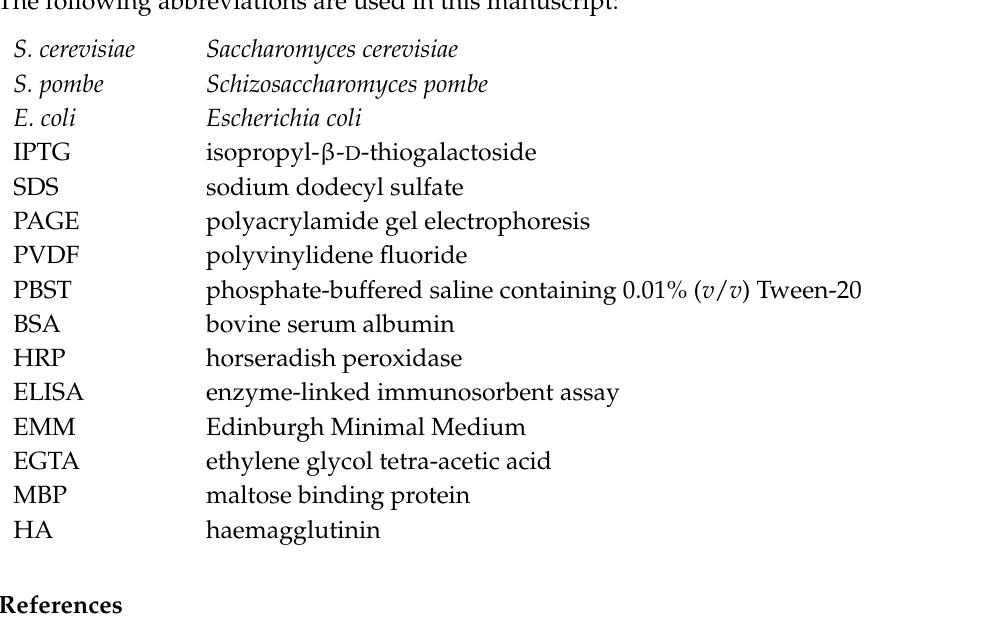
Figure S1: Performing the competitive ELISA under varying conditions, Figure S2: Effect of repeated antibody stripping on the signal height, Figure S3: Performing the inverse ELISA under varying conditions, Figure S4: Structure of authentic and chimeric pheromone genes, Figure S5: Selectivity of the ELISA-based pheromone quantification